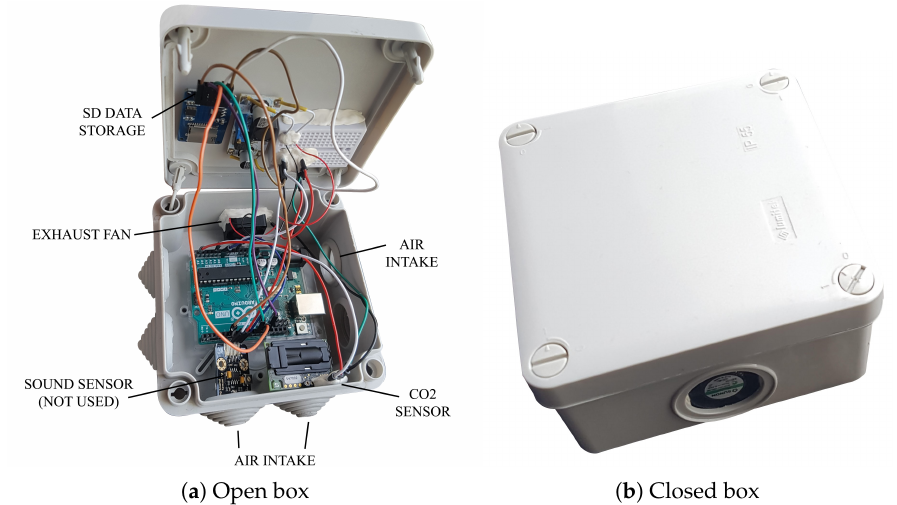
Figure 2. Box with 105 × 105 × 55 mm dimensions containing all the components in Table 1 except the smartphone and